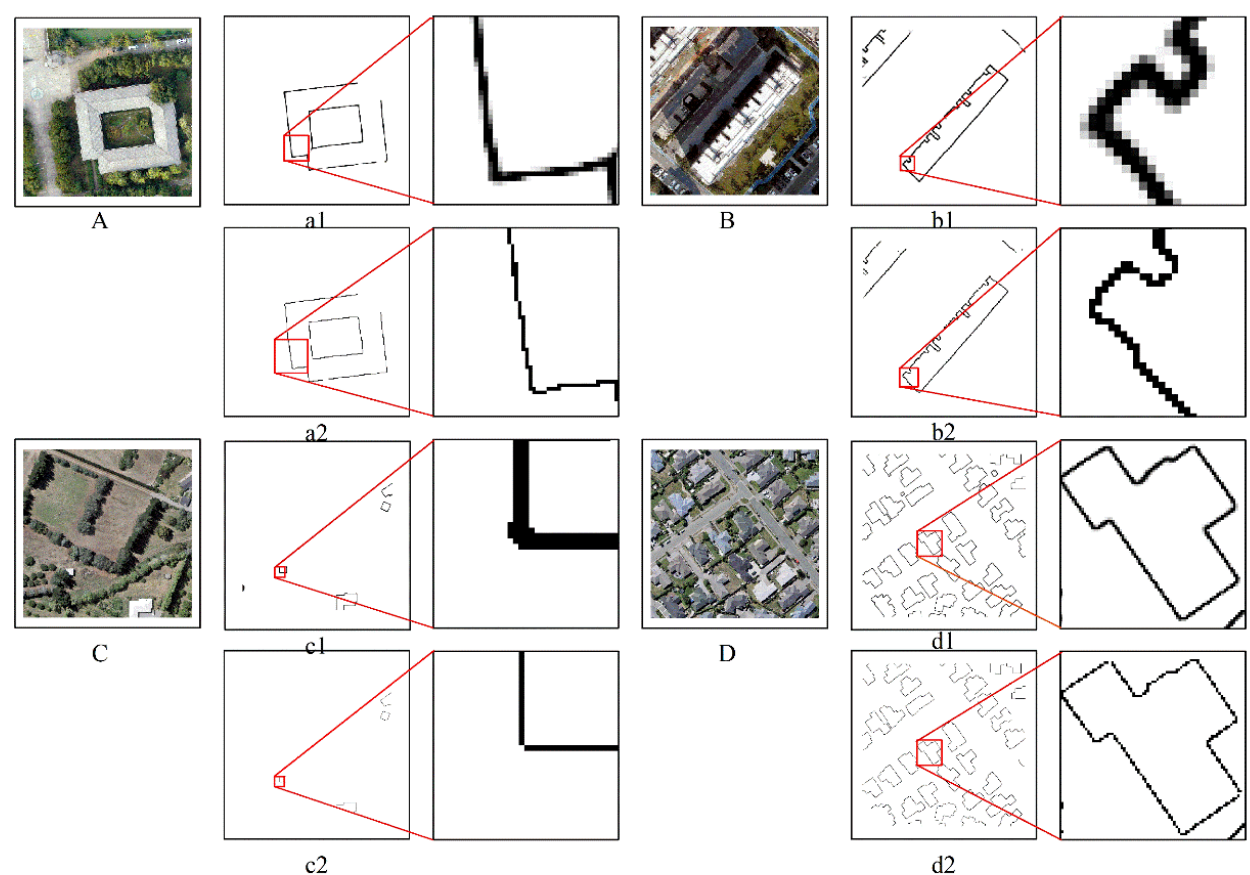
Figure 9. Comparison of building edge details before and after model modification.